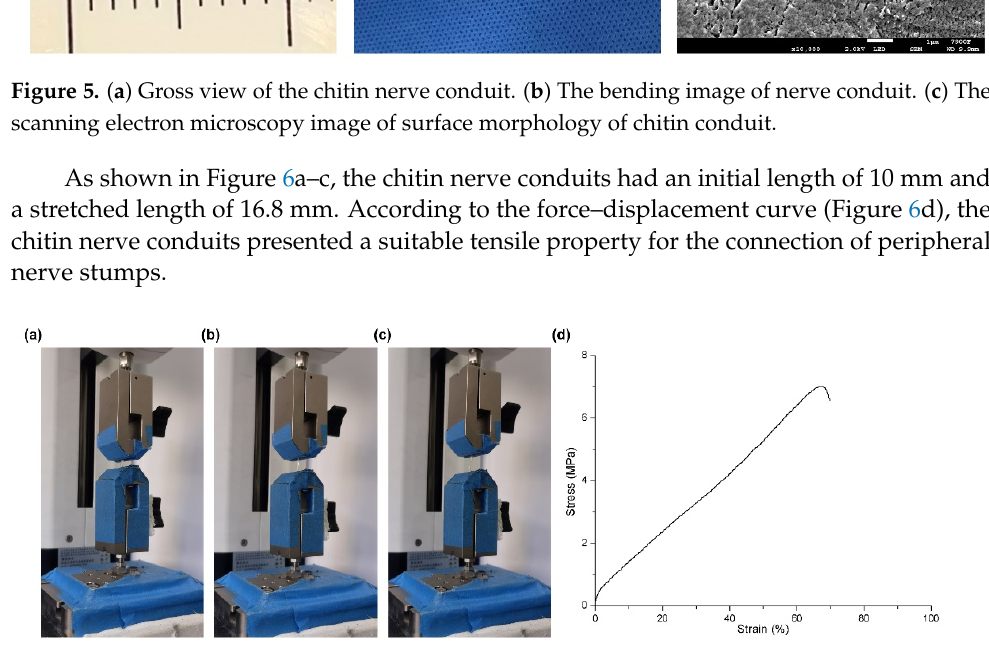
Figure 5. ( a ) Gross view of the chitin nerve conduit. ( b ) The bending image of nerve conduit. ( c ) The scanning electron microscopy image of surface morphology of chitin conduit.